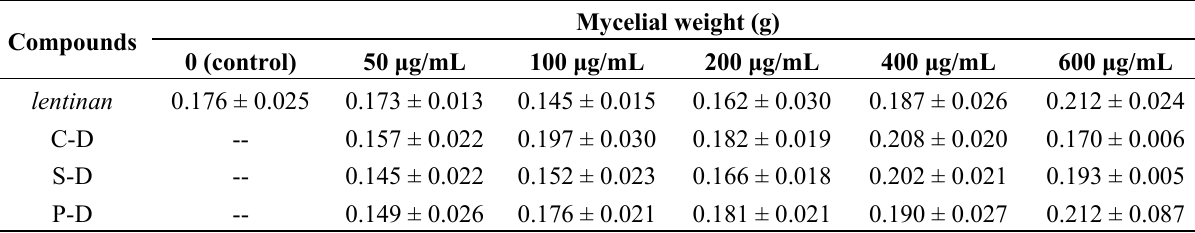
Table 1. The effects of different concentrations of lentinan and its derivatives on the mycelial growth of A. flavus .